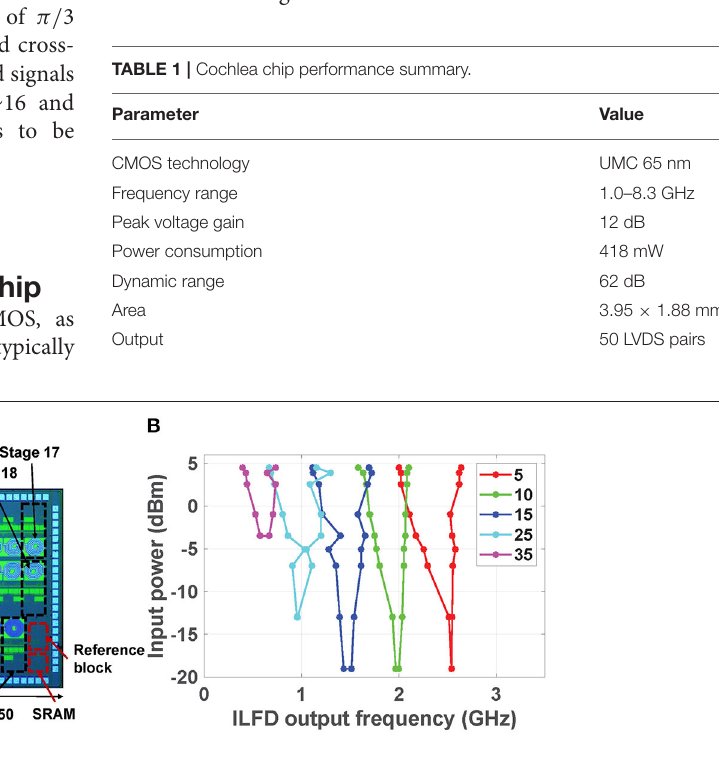
Frontiers in Neuroscience |